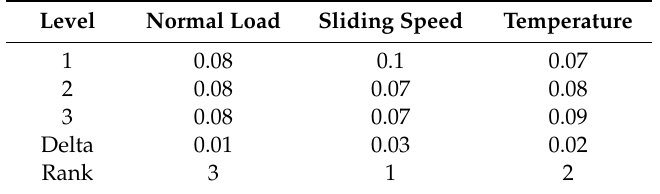
Table 7. Response table for mean SWR showing the ranking of the